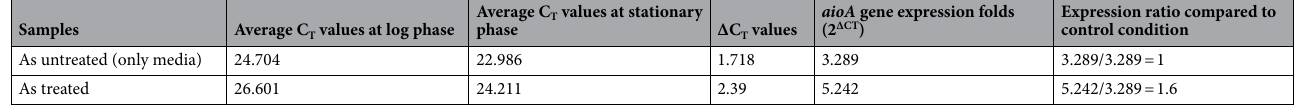
Table 2. Arsenite oxidase gene ( aio A) expression ratios in presence of arsenite comparing with the control condition. Expression of the aio A gene was increased in presence of arsenite compared to untreated cells.